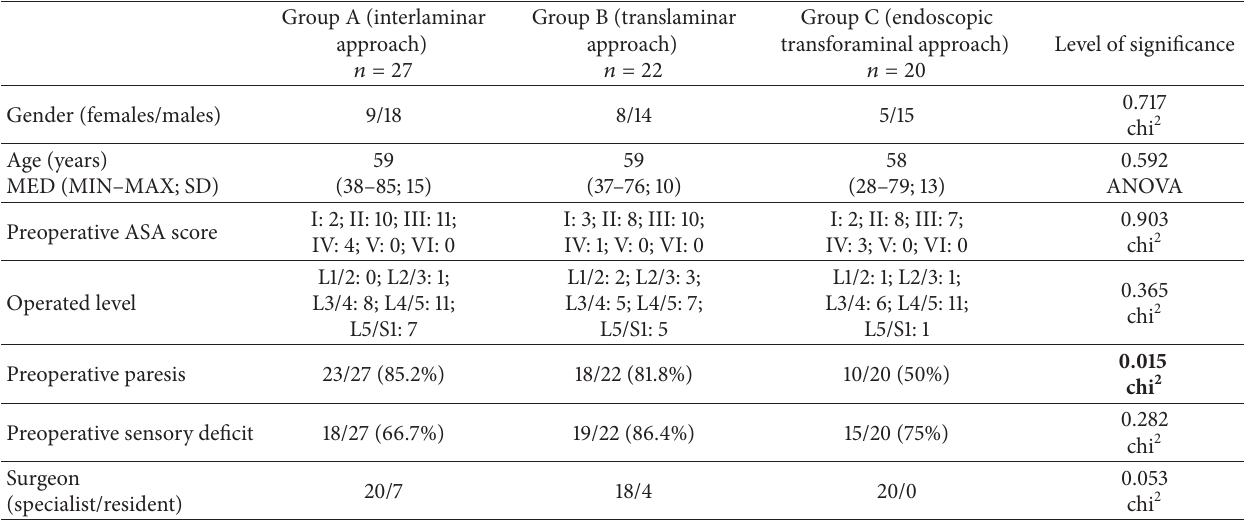
Table 1: Preoperative patient data.